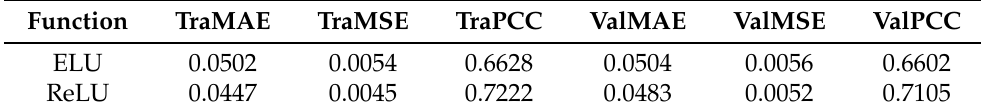
Table 4. Effect of different activation functions on model